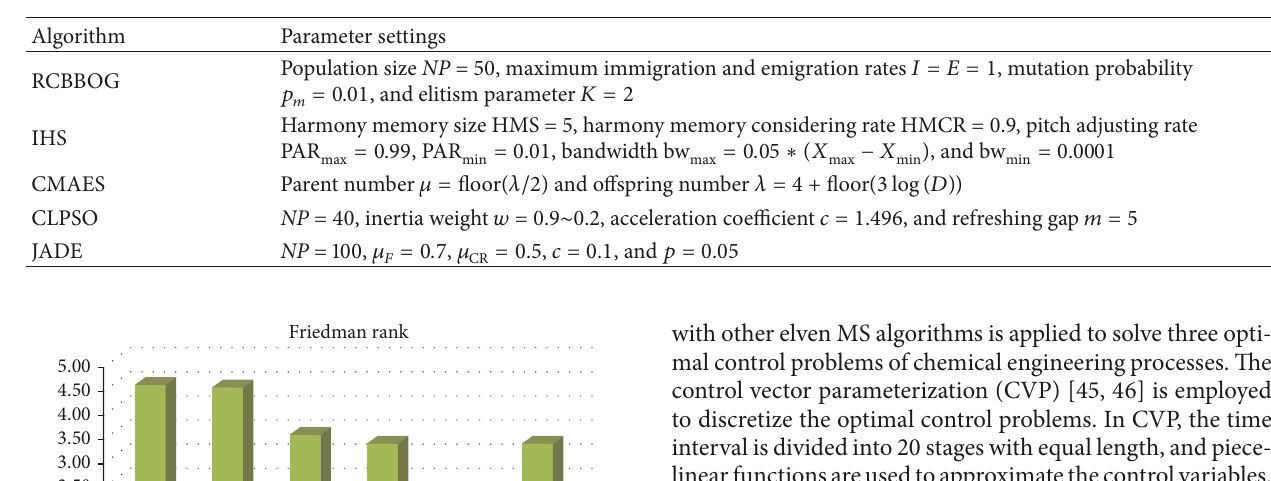
Table 4: Parameter settings for the other MS algorithms.